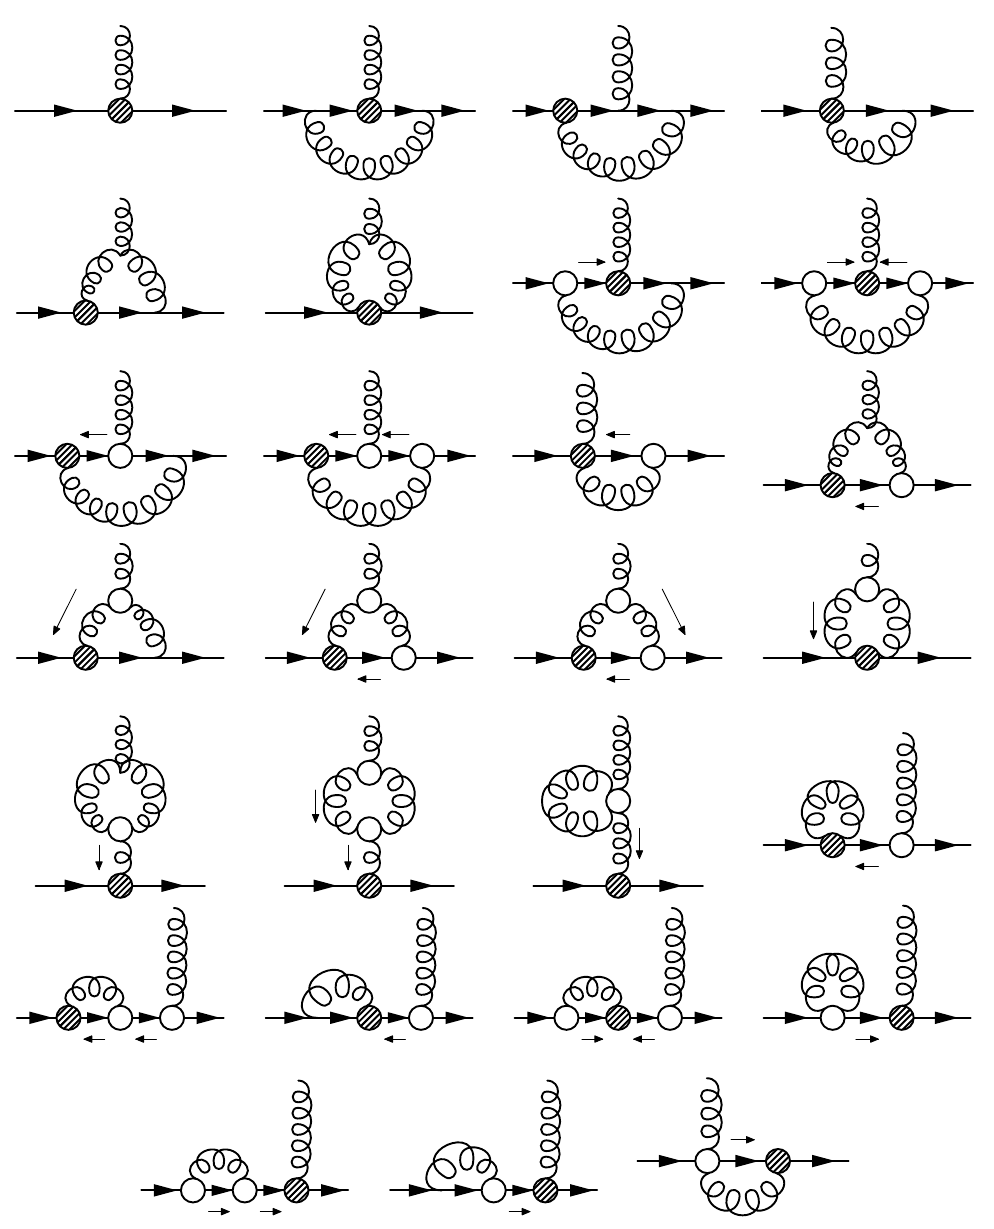
Figure 2 . Feynman diagrams for the matching calculation of the flowed qCEDM operator. We do not show 19 additional diagrams that follow from crossing and inverting the fermion-flow direction. The hatched blob denotes the insertion of the flowed qCEDM operator at flow time t , while the open circles are flow vertices. Normal quark and gluon lines denote propagators, while lines with an adjacent arrow stand for flow lines. The adjacent arrow points into the direction of increasing flow